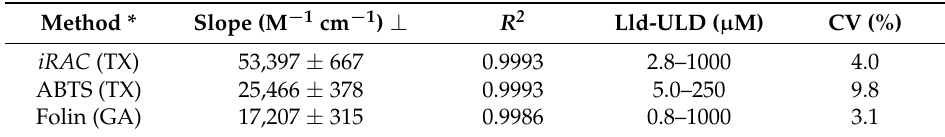
Table 1. Calibration parameters for iRAC , ABTS, and Folin–Ciocalteu assays.